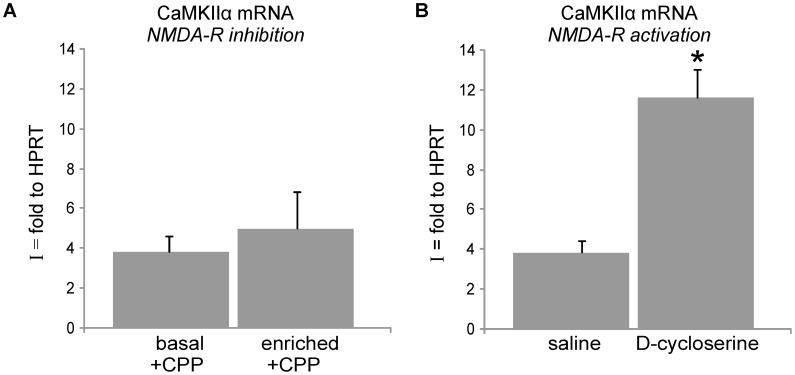
CaMKIIα mRNA synaptic localization is regulated by NMDAR.
A, NMDAR antagonist: 30 min prior to the 30 min olfactory enrichment protocol, mice were injected with CPP. Upon 30 min of olfactory enrichment, the synaptic localization index remains unchanged as compared to basal conditions. NMDA receptor blockade thus prevents the increase in CaMKIIα mRNA observed upon olfactory enrichment (compare with B) (n = 3; p = 0.6, t-test). B, NMDAR agonist: mice were injected with D-cycloserine or saline. 30 min after injection, the index of synaptic localization is increased 3.4-fold as compared to saline, thus recapitulating the effect of olfactory enrichment on CaMKIIα mRNA localization (compare with B) (n = 2 for saline, n = 3 for D-cycloserine; *p = 0.02, t-test).